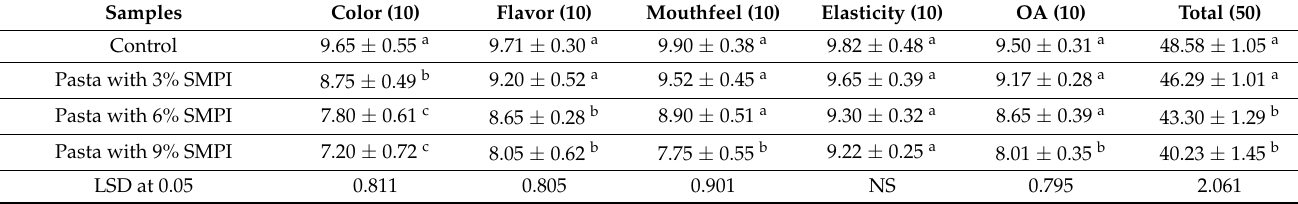
Table 8. Impact of mixing SMPI with wheat flour on the sensory properties of